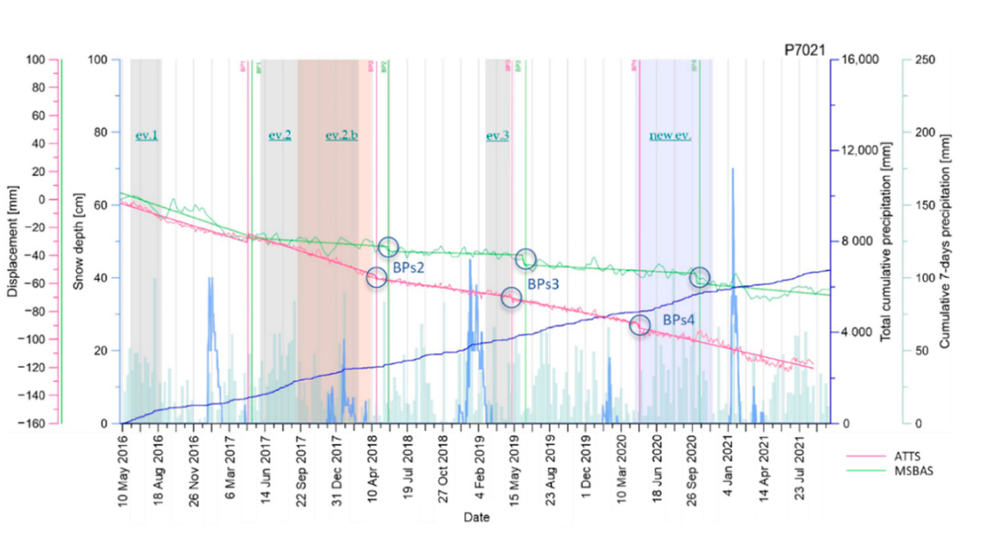
Figure 10. Horizontal (EW) displacement time series correlation of ATTS (red) against MSBAS (pur ‐ ple) for the intersection zone. Evaluation of Trends and BPs of point n. P6432 plotted against total cumulative precipitation (dark blue line), cumulative 7 ‐ days precipitation (histogram), and snow depth (light blue line).